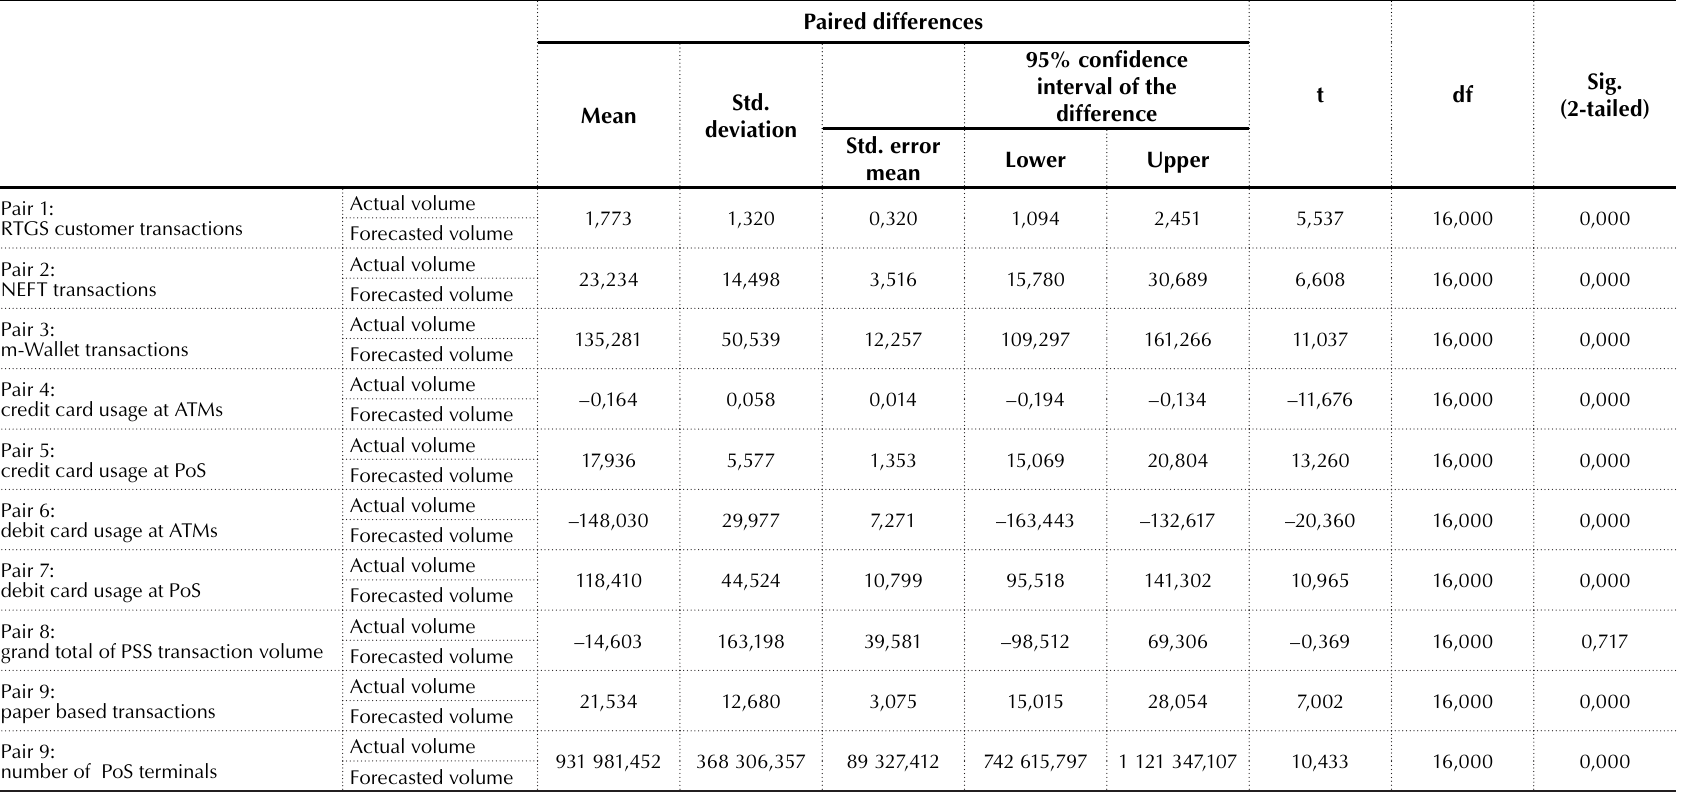
Paired differences